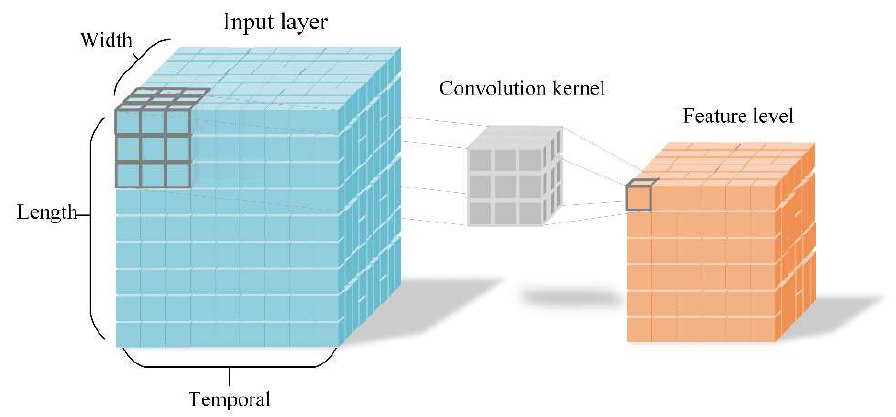
Figure 2. Process representation of 3DCNN .